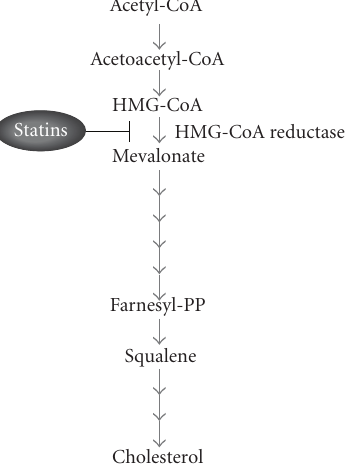
Figure 1: Schematic colesterol biosynthetic pathway. Statins lower cholesterol synthesis by inhibiting 3-hydroxy-3-methylglutaryl coenzyme A (HMG-CoA)